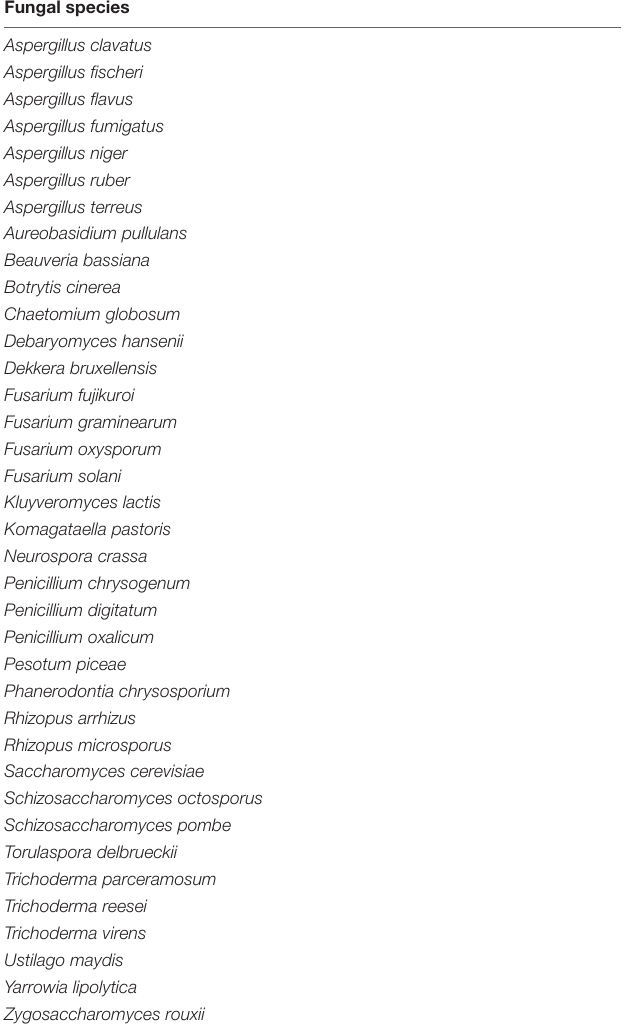
TABLE 2 | List of fungal species analyzed in this